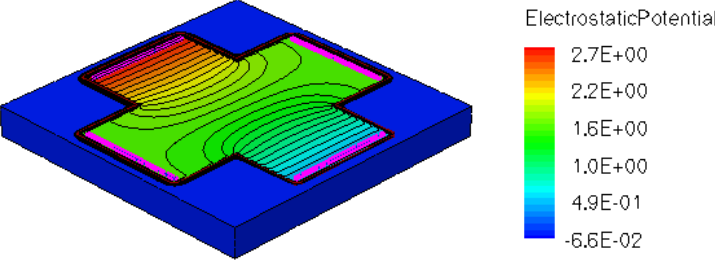
Figure 10. Electrostatic potential (V) for XL structure, B = 0.5 T.